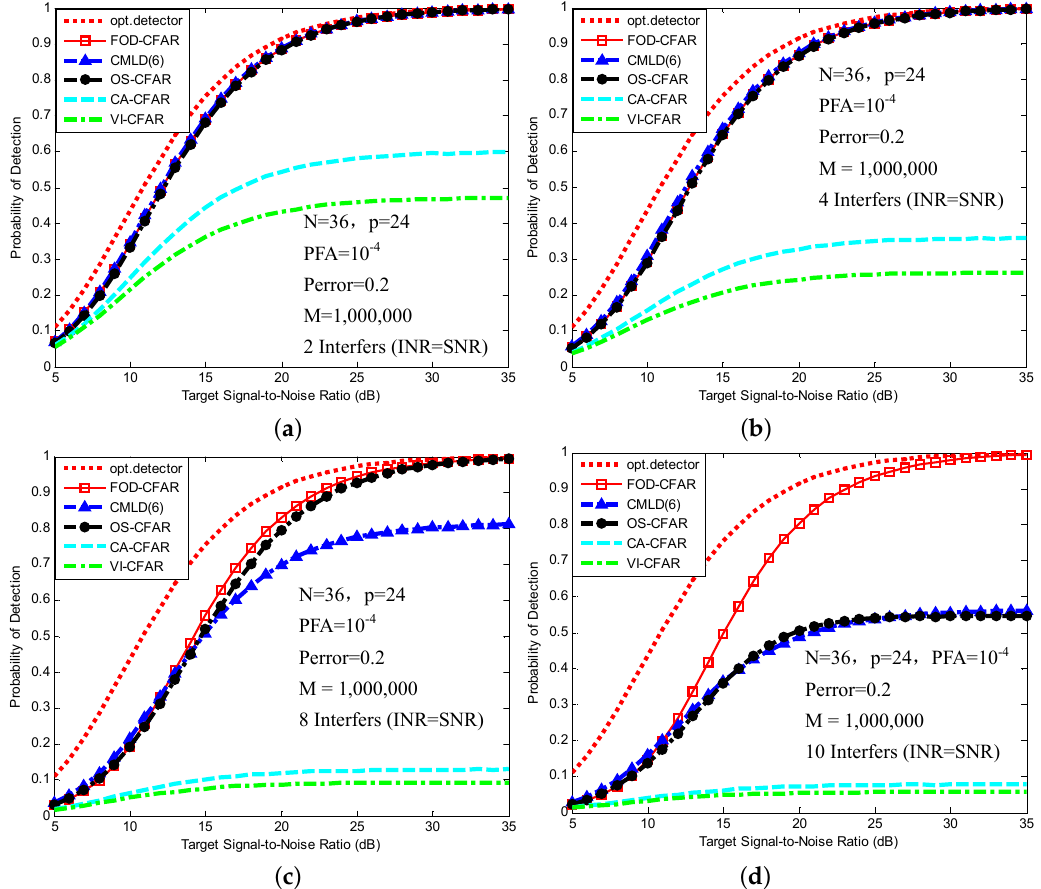
Figure 8. PD comparison of FOD-CFAR, CMLD(6), OS-CFAR, CA-CFAR and VI-CFAR in multiple target situations: ( a ) Two interference targets; ( b ) Four interference targets; ( c ) Eight interference targets; and ( d ) Ten interference